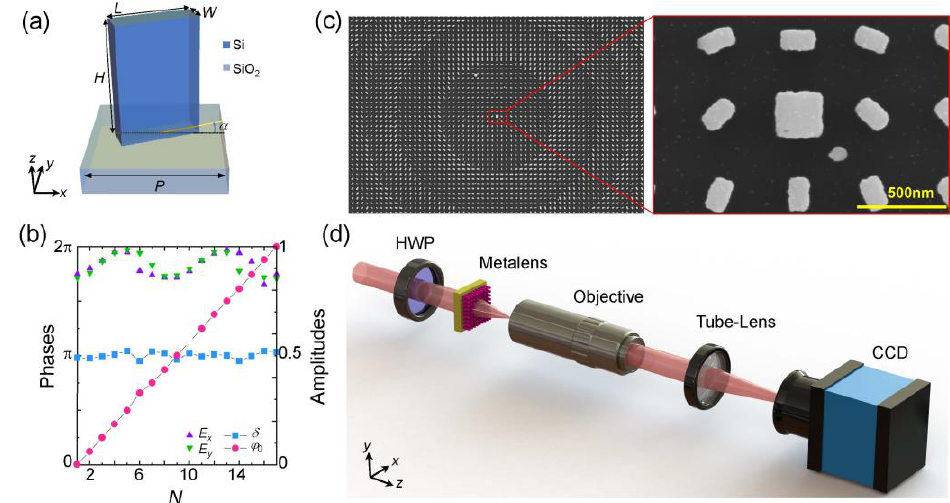
Figure 3. Design and characterization of the metalens. ( a ) Schematic illustration of an element consisting of a poly-Si nanopillar and glass substrate. The geometric parameters of the element are denoted as H (height), L (length), W (width), and P (period), the rotation angle is denoted as α ; ( b ) Transmission amplitude ( E x and E y ) and phase retardation [ δ = ϕ x − ϕ y and ϕ 0 = ( ϕ x + ϕ y )/2] of eigenstates within 16 selected elements; ( c ) Scanning electron microscope images of the metalens and its local structure. The sample is composed of 800 × 800 elements with a lattice constant of 450 nm along x - and y -axes. The scale bar is 500 nm; ( d ) Sketch of experimental setup, HWP: half-wave plate.